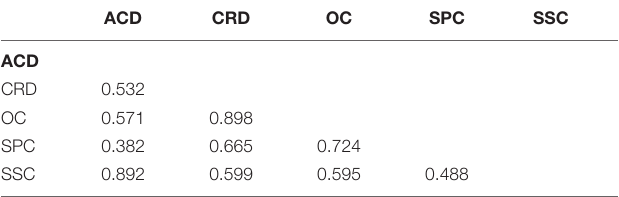
TABLE 2 | Factor loadings, reliabilities, and average variance extracted (AVE). TABLE 3 | The heterotrait-monotrait (HTMT)